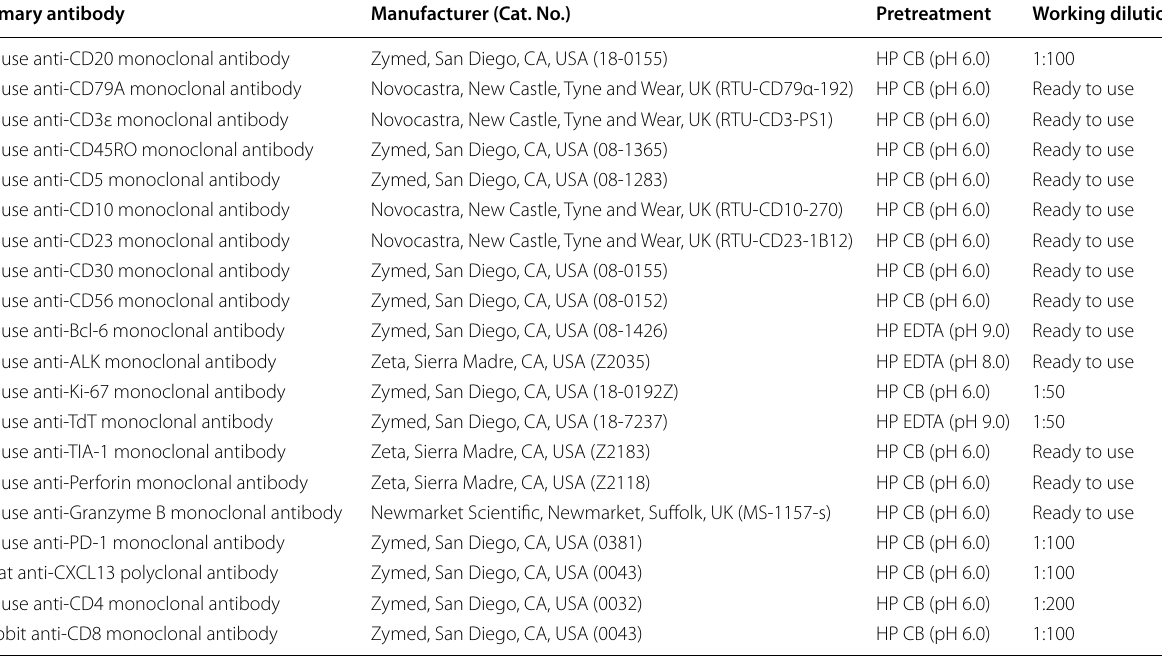
HP high pressure (boiled with buffer in a stainless steel high-pressure cooker for 10 min, with the pressure setting at approximately 103 kPa), CB 0.01 mol/L citrate buffer, EDTA 0.01 mol/L ethylenediaminetetraacetic acid, Bcl-6 B-cell lymphoma-6, ALK anaplastic large cell lymphoma kinase, TdT terminal deoxynucleotidyl transferase, TIA-1 T-cell-restricted intracellular antigen-1, PD-1 programmed cell death 1, CXCL13 C-X-C motif chemokine ligand